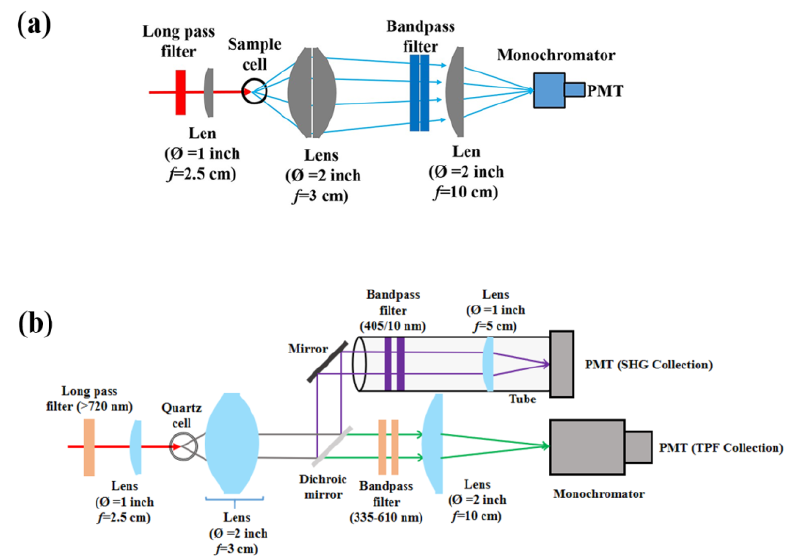
Figure 3. ( a ) Experimental setup for collecting the scattered signal at a relatively large spatial angle. Reproduced with permission [57]. Copyright 2019 American Chemical Society. ( b ) Setup for sim- ultaneously detecting the SHG and TPF signals. Reproduced with permission [61]. Copyright